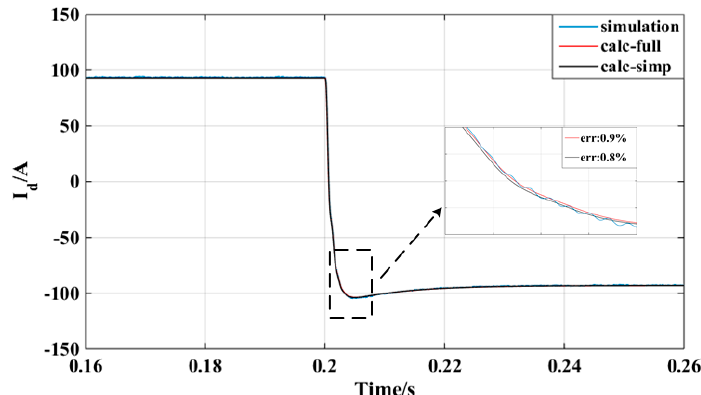
Energies 2019 , 12 , x FOR PEER REVIEW 13 of 17 Figure 9. The waveform of output dc bus voltage (power inversion). Figure 9. The waveform of output dc bus voltage (power inversion). Figure 9. The waveform of output dc bus voltage (power inversion).